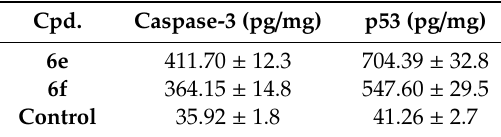
Table 4. E ff ect of compounds 6e and 6f on the expression levels of active caspase-3 and p53 in MCF-7 cancer cells.